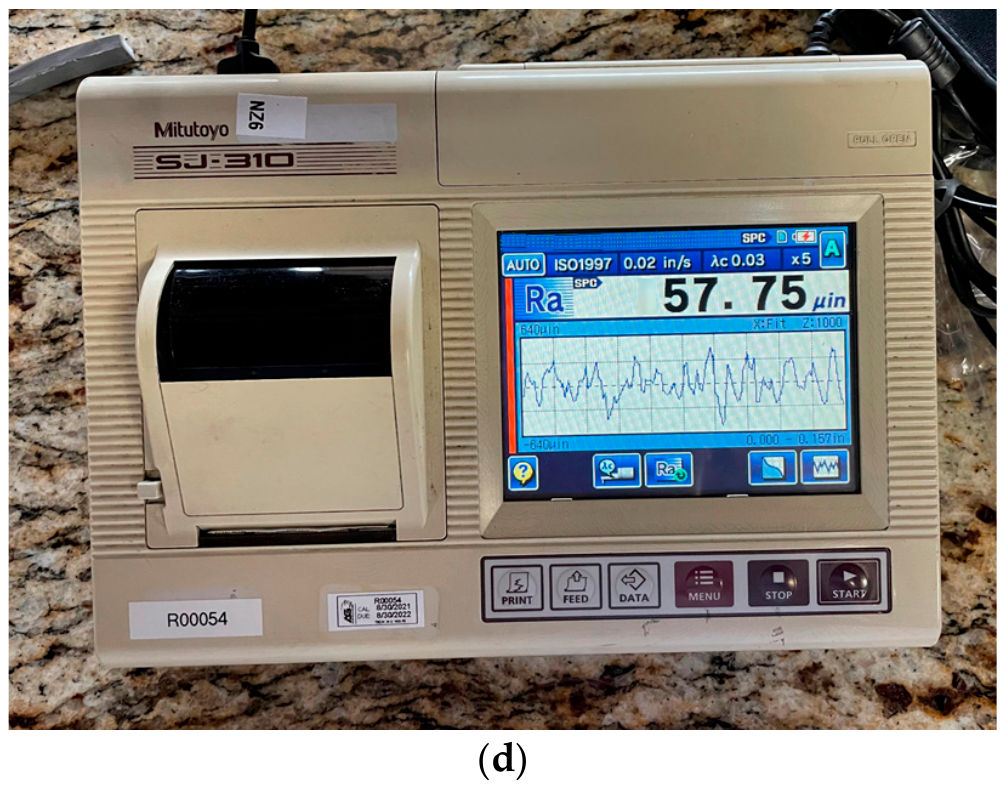
Figure 1. ( a ) Schematic of the nanoparticle-enhanced MQL experimental setup. ( b ) Actual experimental setup. ( c ) Laser thermometer used in this study. ( d ) Surface profilometer used in this study. Table 3. Technical instruments used in this study.